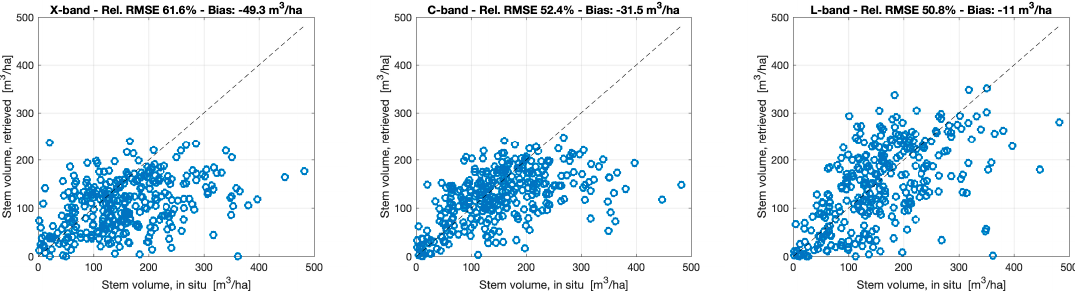
Figure 12. Scatter plots of measured and retrieved stem volume at Krycklan for a multi-temporal and multi-polarization combination of estimates obtained at a given frequency band.